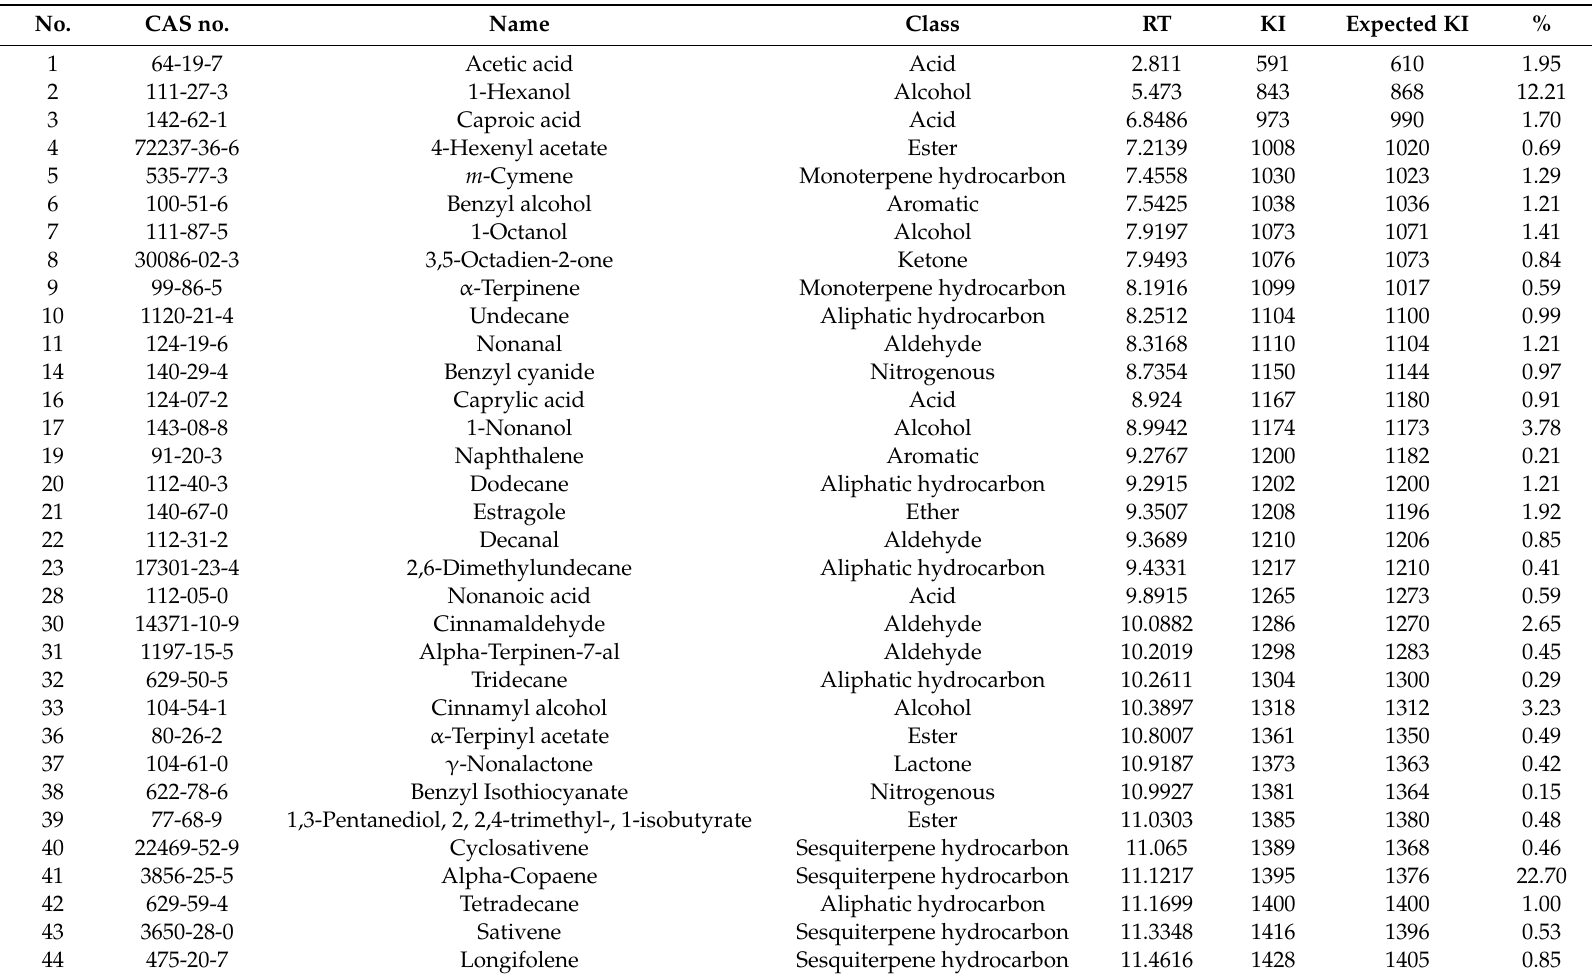
Table 3. Relative percentage of components in L. sativum seed analyzed using solid-phase microextraction (SPME)-GC-MS, n =